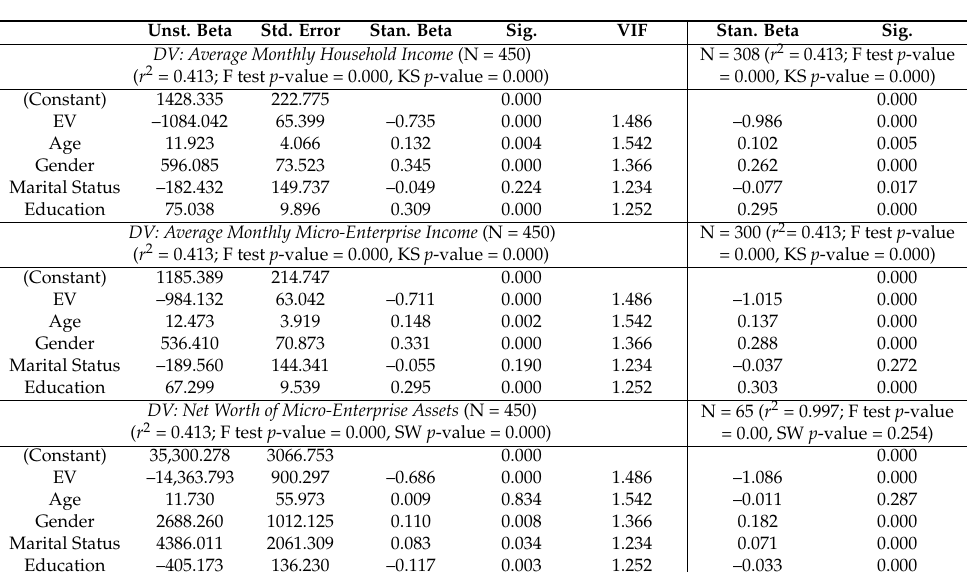
Table 6. The regression